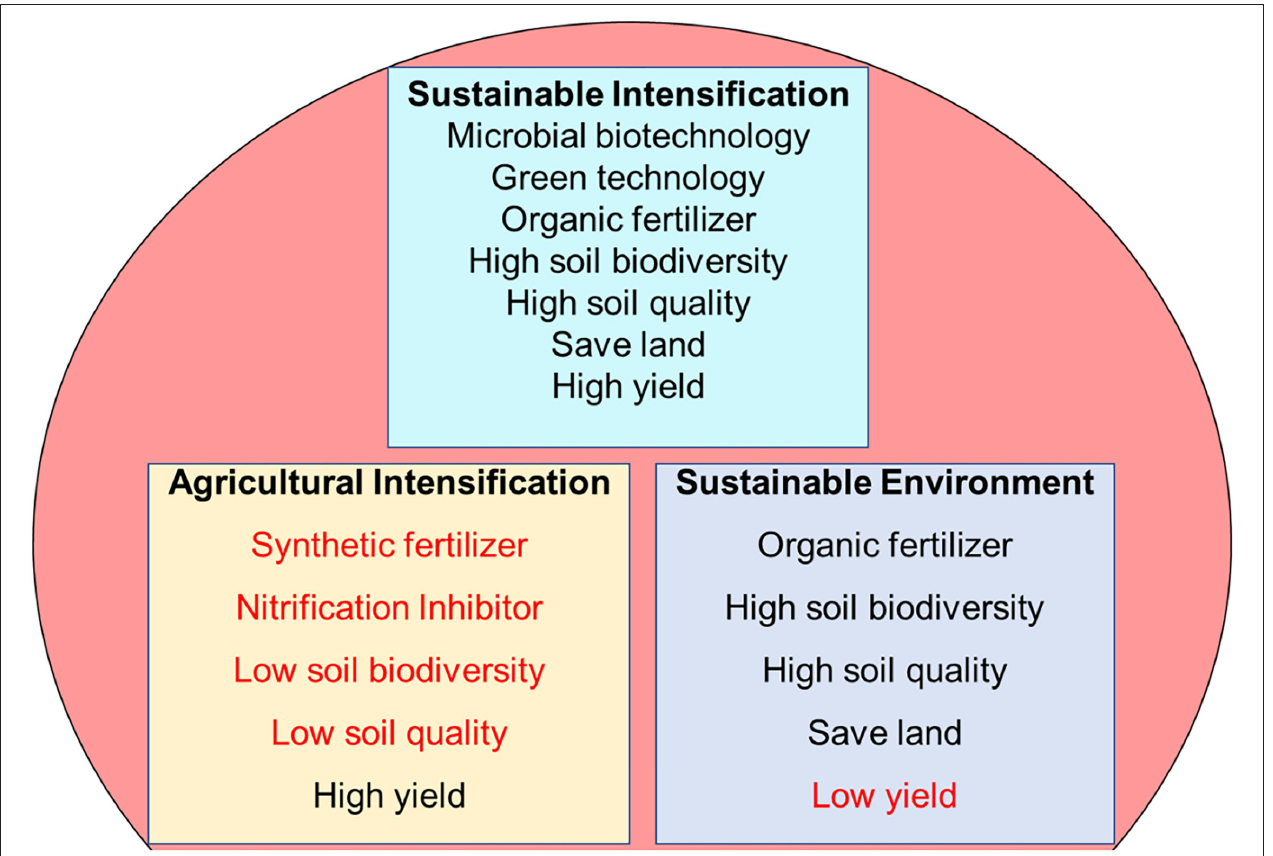
FIGURE 1 | Components of sustainable intensification, agricultural intensification, and sustainable